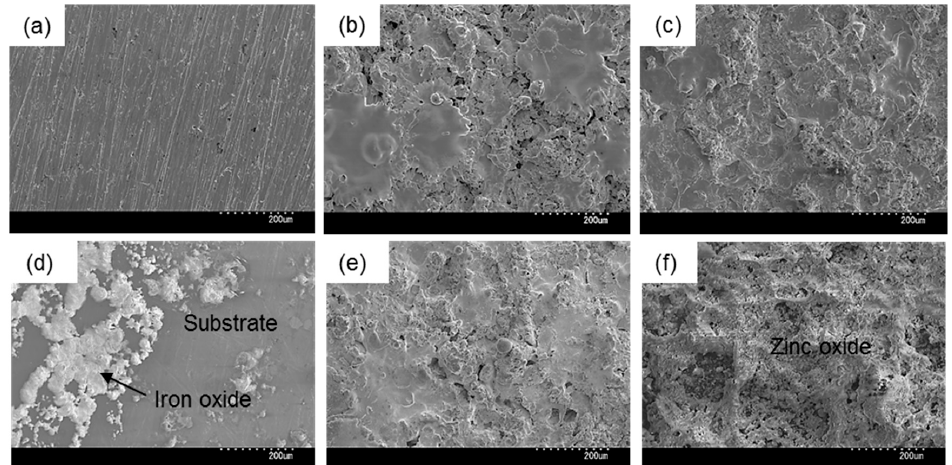
Figure 5. SEM images of the surface of coupons before ( a–c ) and after ( d–f ) outdoor exposure. ( a ) and ( d ) SS400; ( b ) and ( e ) Cu-coated; ( c ) and ( f ) Zn-coated.